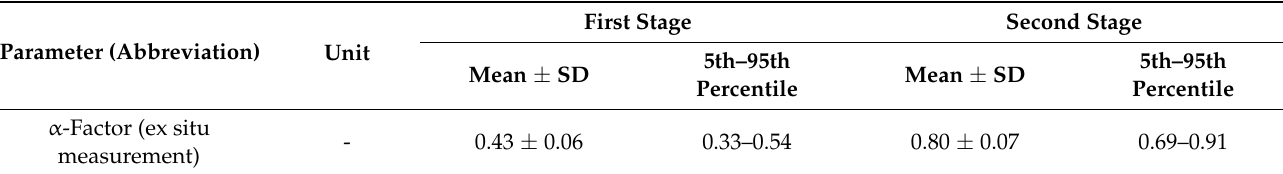
Table 2. α -factors determined with ex situ off-gas measurements in a two-stage